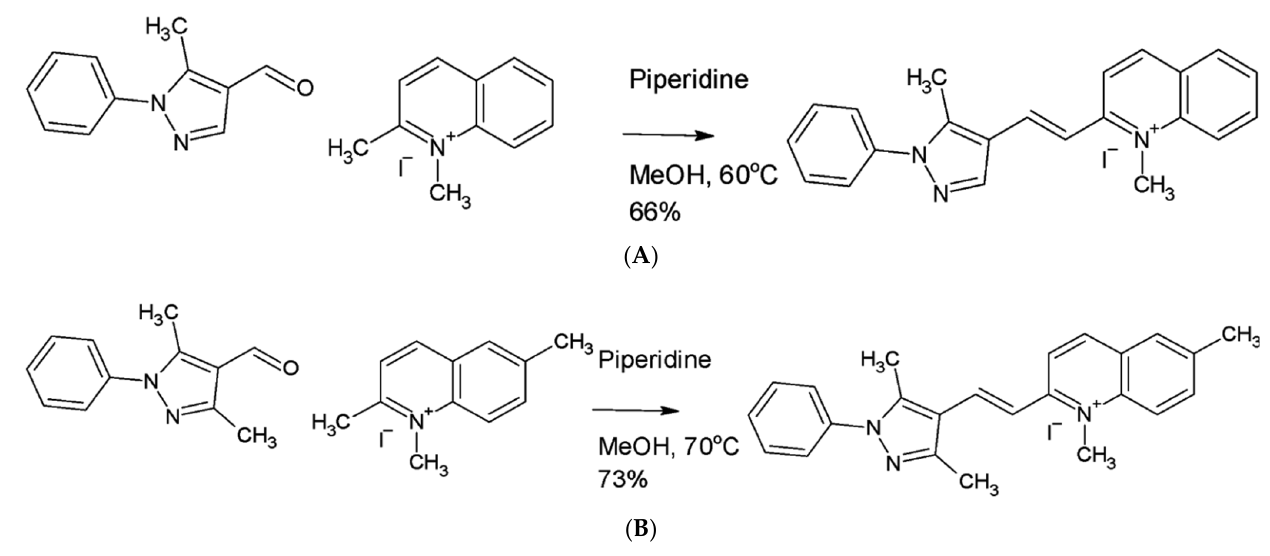
Figure 6. ( A ) Synthesis of analog 03. ( B ) Synthesis of analog